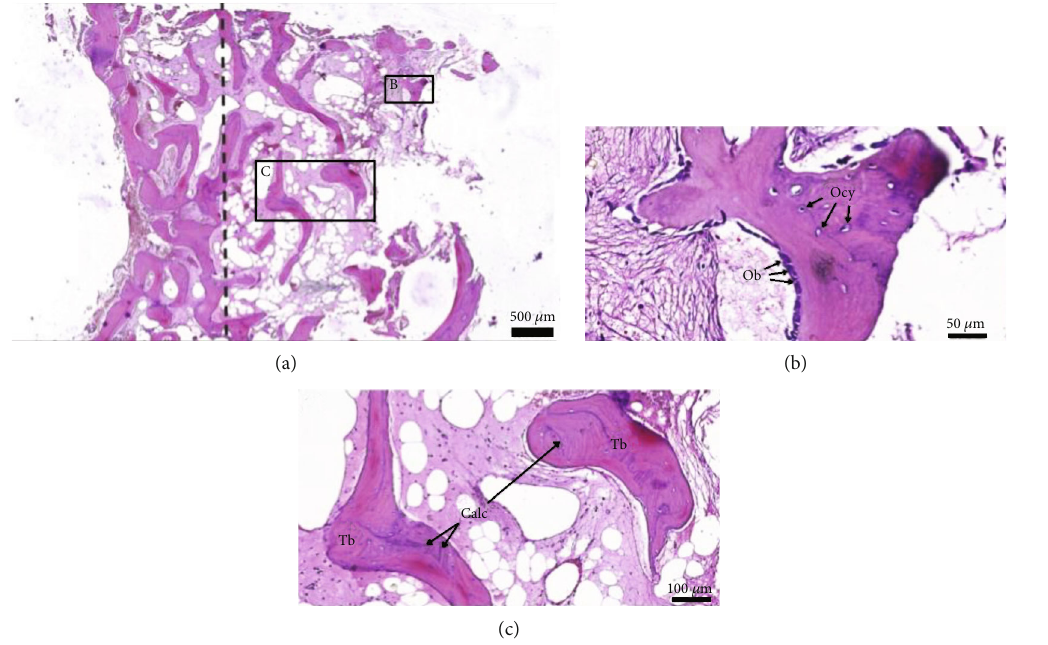
Figure 2: (a) Low-magni fi cation image of the histopathological evaluation using H&E staining of the 6-month postoperation bone core specimen. The dashed line represents the border between the pre- and postoperation residual bone. (b) High-magni fi cation image demonstrates active cuboidal osteoblasts (Ob) and osteocytes (Ocy) in lacunae. (c) High-magni fi cation image shows thick trabeculae (Tb), bone lacunae, and calci fi cation zone